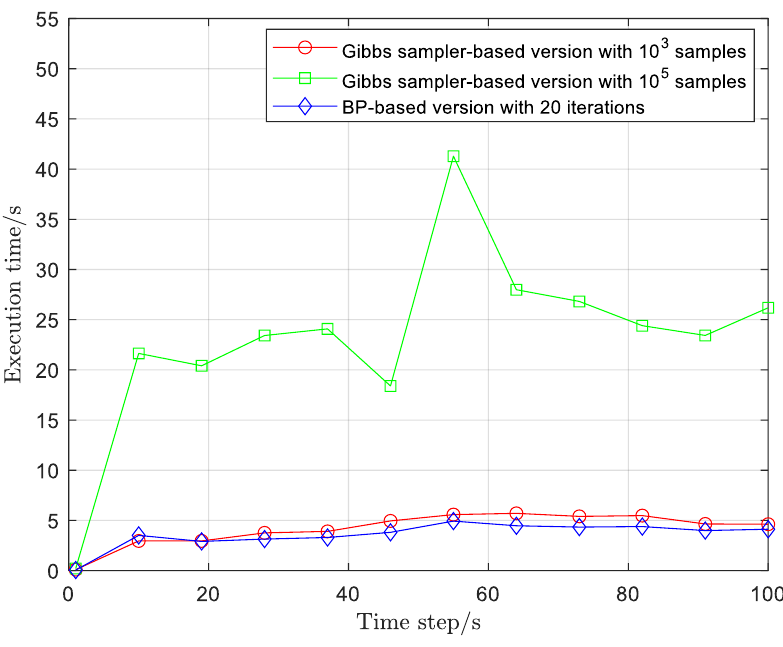
Figure 8. The total runtime of the different methods.